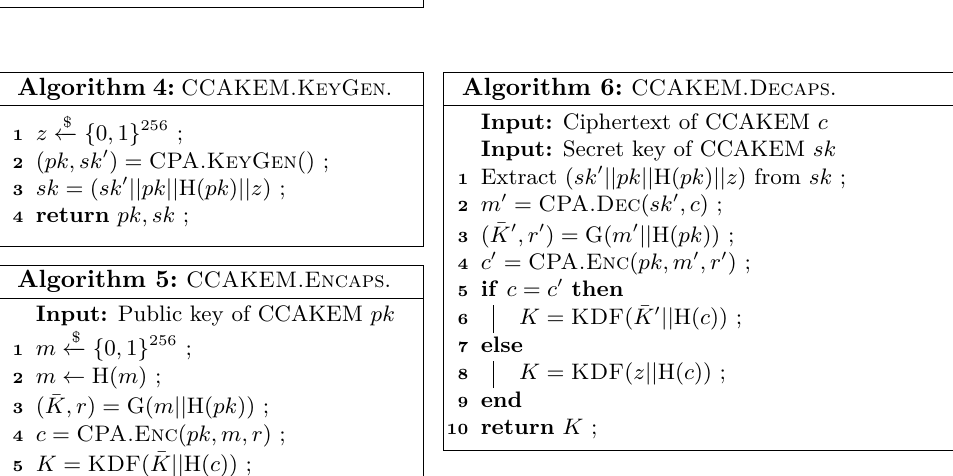
Algorithm 5: CCAKEM.Encaps .